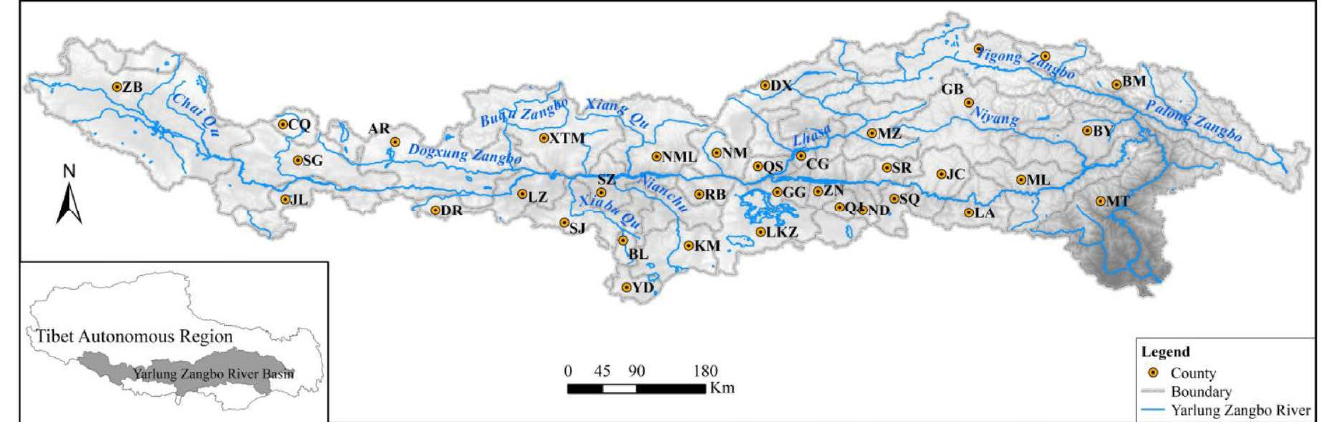
Figure 1. The study area map includes the Yarlung Zangbo River Basin and its covered administrative region. County Codes: ZB, Zhongba; SG, Saga; CQ, Cuoqing; JL, Jilong; AR, Angren; DR, Dingri;